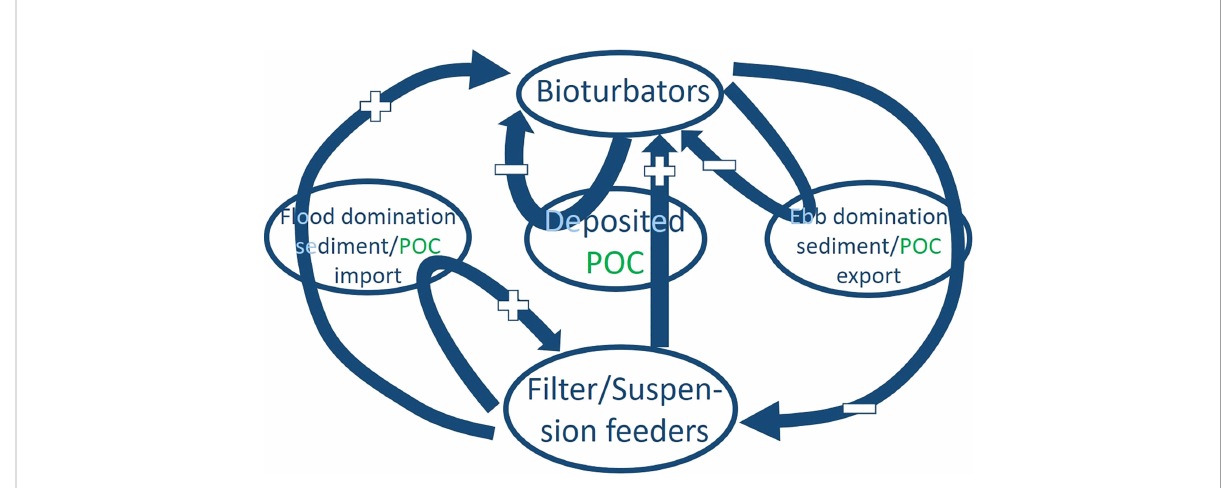
FIGURE 11 Illustration of feedback between two major functional groups in terms of growth ( “ + ” ) or decline ( “ - ” ) in biomass. Internal feedback within each of the group is also